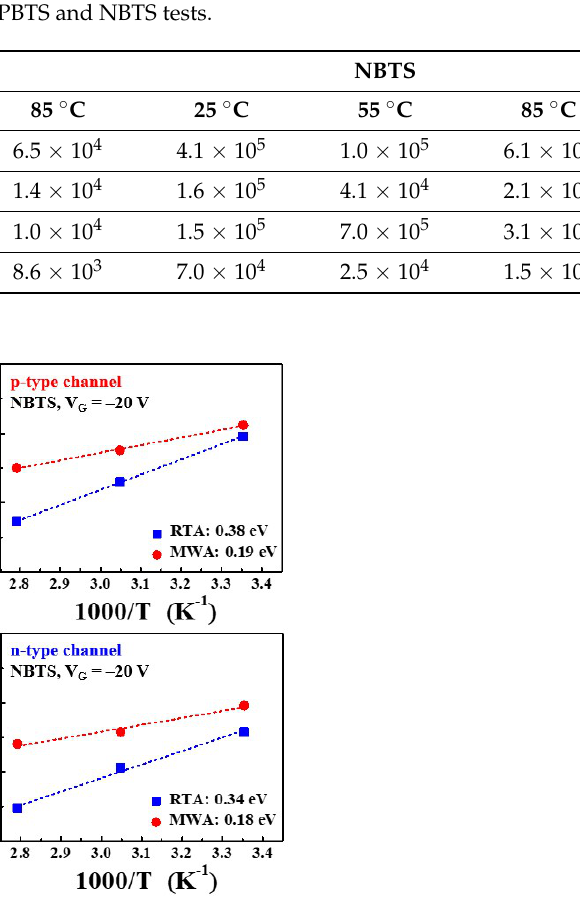
Figure 10. The charge trapping time (τ) of the MWA- and RTA-NiSi x SB-TFTs during the PBTS and NBTS tests as a function of temperature for the p-channel (a) , and n-channel (b) modes. Table 4. The average effective energy barrier height (E τ ) of the MWA- and RTA-NiSi x SB-TFTs ob- tained from the PBTS and NBTS tests. Average effective energy barrier [eV] Conduction Silicidation PBTS NBTS